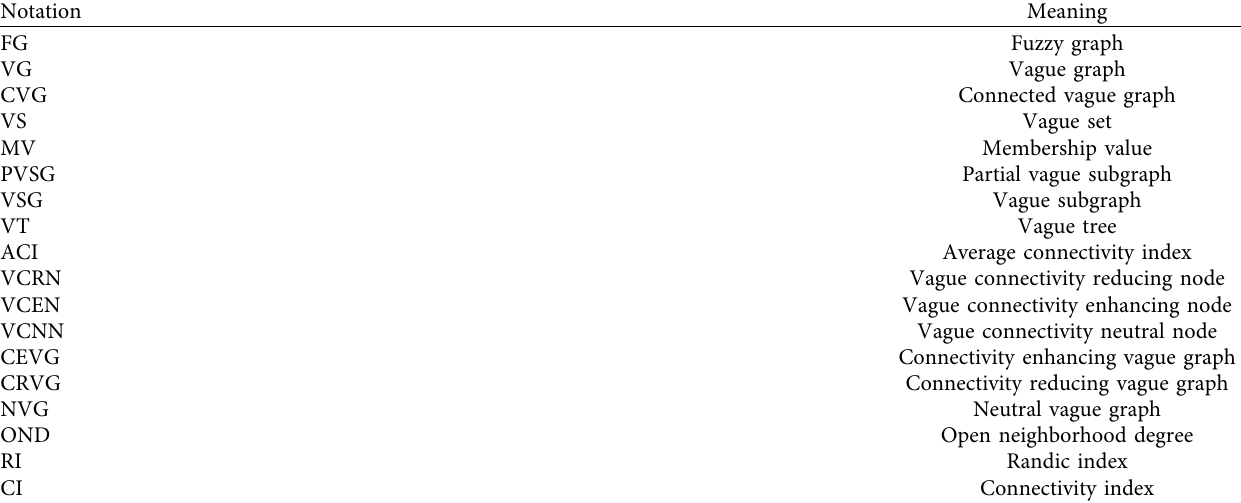
Table 1: Some basic